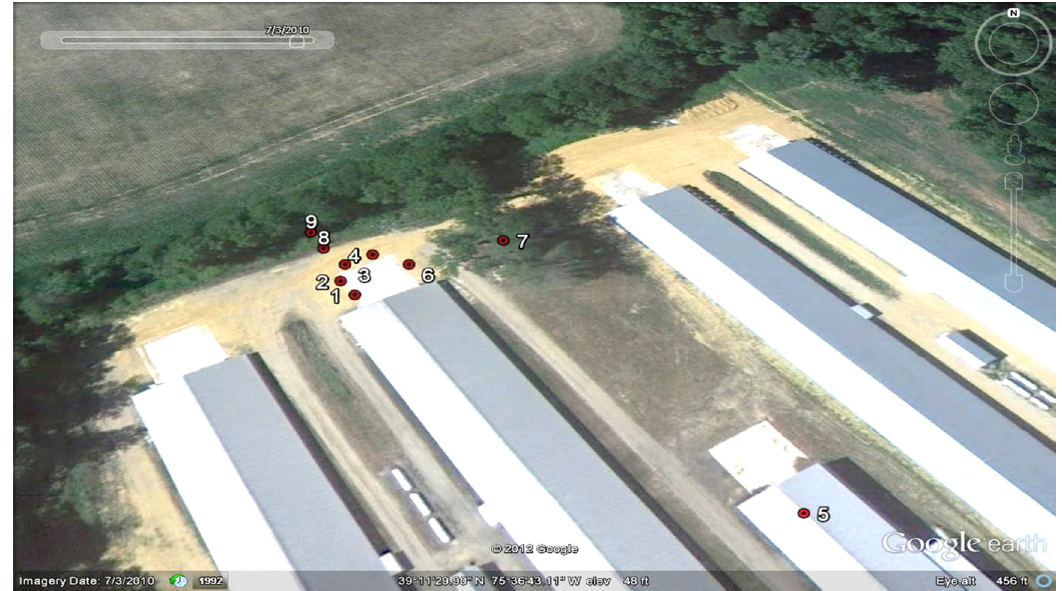
Figure 2. Aerial view showing the soil sampling points in the farm—Site I. Numbers in figure denotes sampling locations. Please see table 1 for the specific sites descriptions.